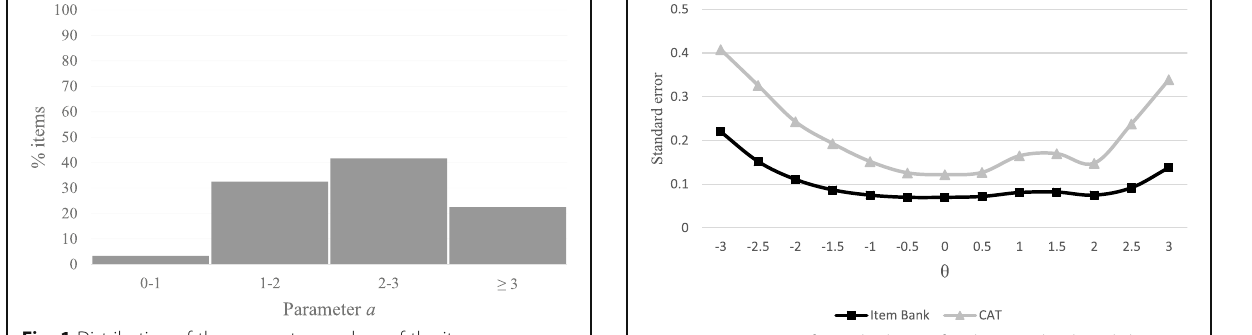
Fig. 3 Comparison of standard error for the item bank and the